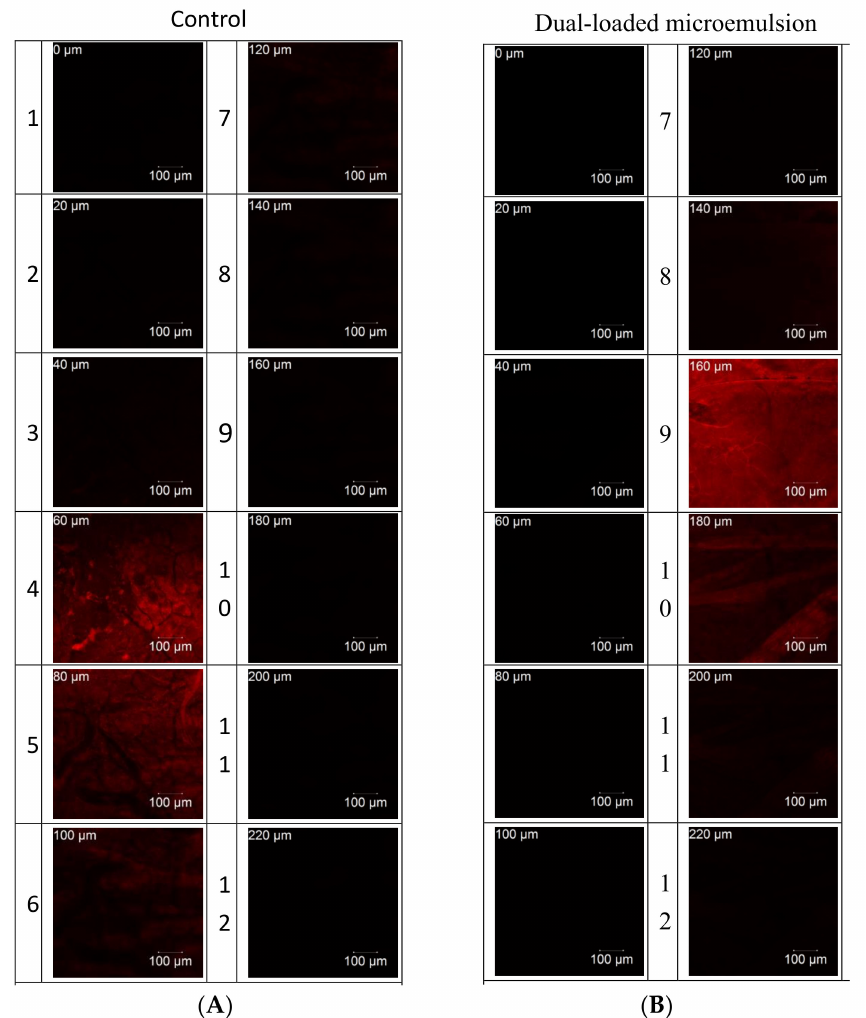
Figure 4. Confocal Laser Scanning Microscope micrographs of bladder tissue after in vivo application of dual microemulsion for 1 h. ( A ) Aqueous control solution; ( B ) dual-loaded microemulsion of F3 containing 1% gemcitabine, 0.1% cisplatin, and 0.1% rhodamine. Numbers (1~12) indicate the number of layers, each layer is 20 µ